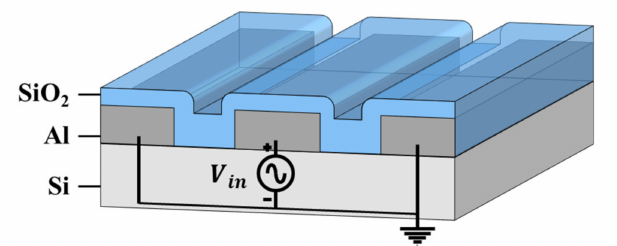
Figure 9. The buried metal sample used to analyze the performance of ToGoFET